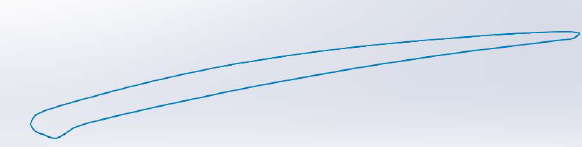
Figure 7. Blade section